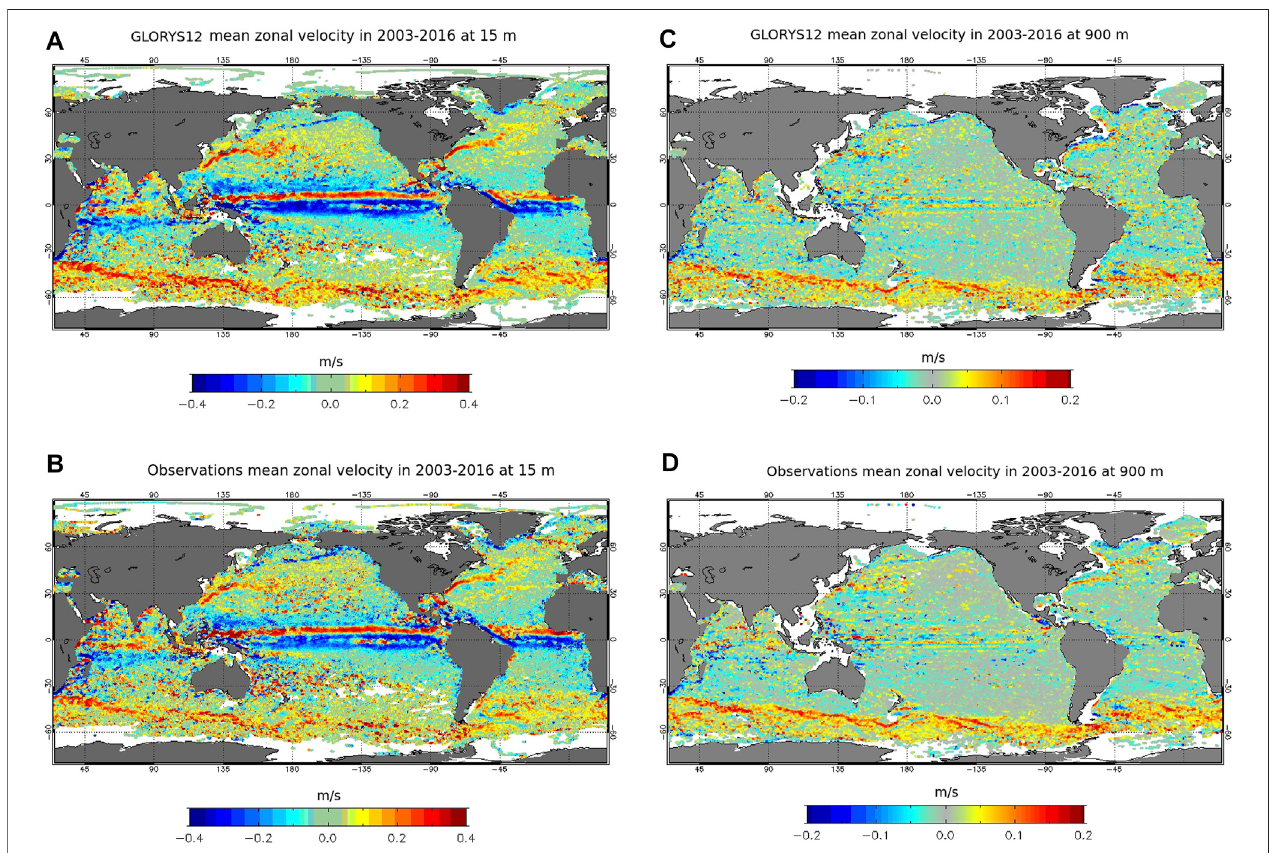
FIGURE9| Panels (A,B) :meanzonalvelocityat15 moverthe2003 – 2016periodforGLORYS12 (A) andobservations (B) .Observationscomefromdrogued-only subsurface drifters (Rio and Etienne, 2019). Panels (C,D) : mean zonal velocity at 900 m over the 2003 – 2016 period for GLORYS12 (C) and observations (D) . Observations come from estimated velocities derived from Argo pro fi ling fl oats (Lebedev et al., 2007). Units are m/s.